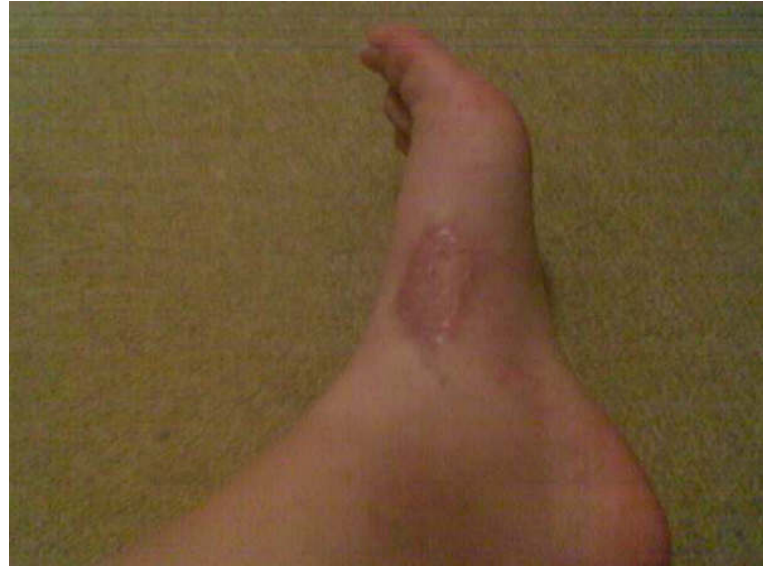
Figure 6. Healing wound after five months, there was a